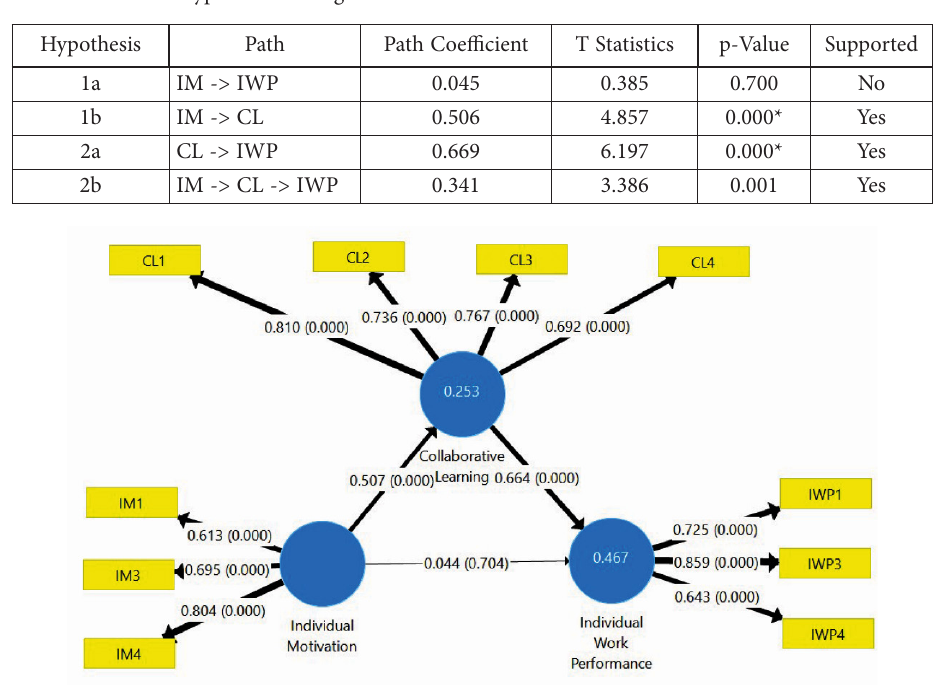
Figure 2. The final structural equation